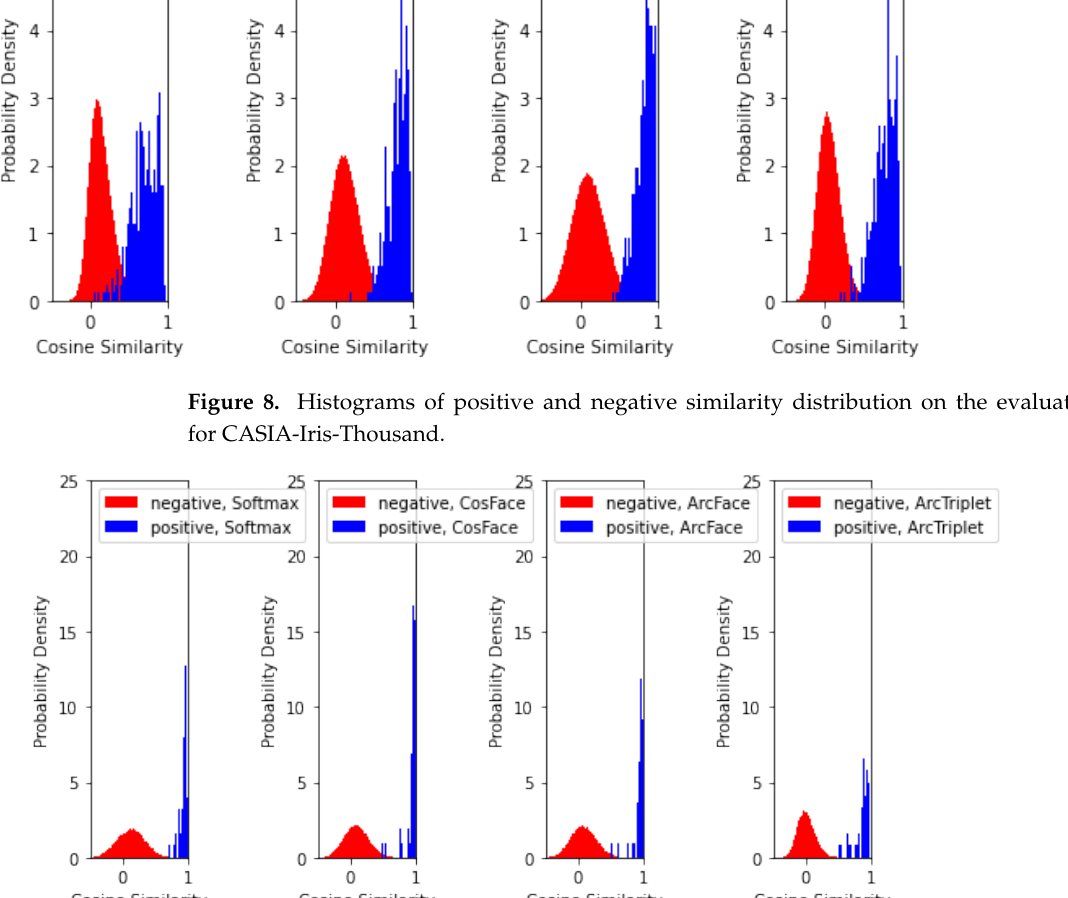
Figure 9. Histograms of positive and negative similarity distribution on the evaluating result for